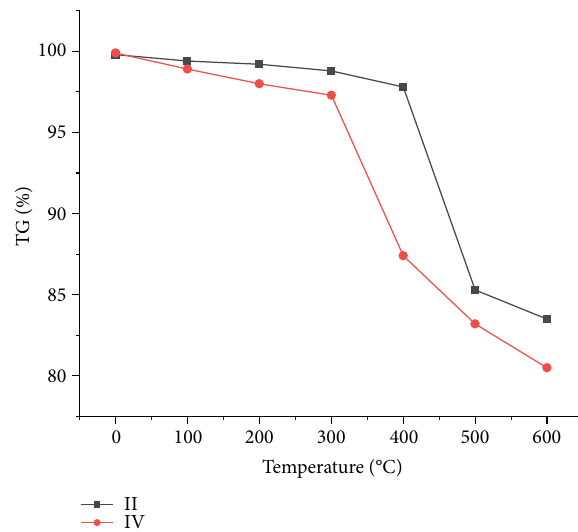
Figure 8: TG map of oil shale specimens No. II and